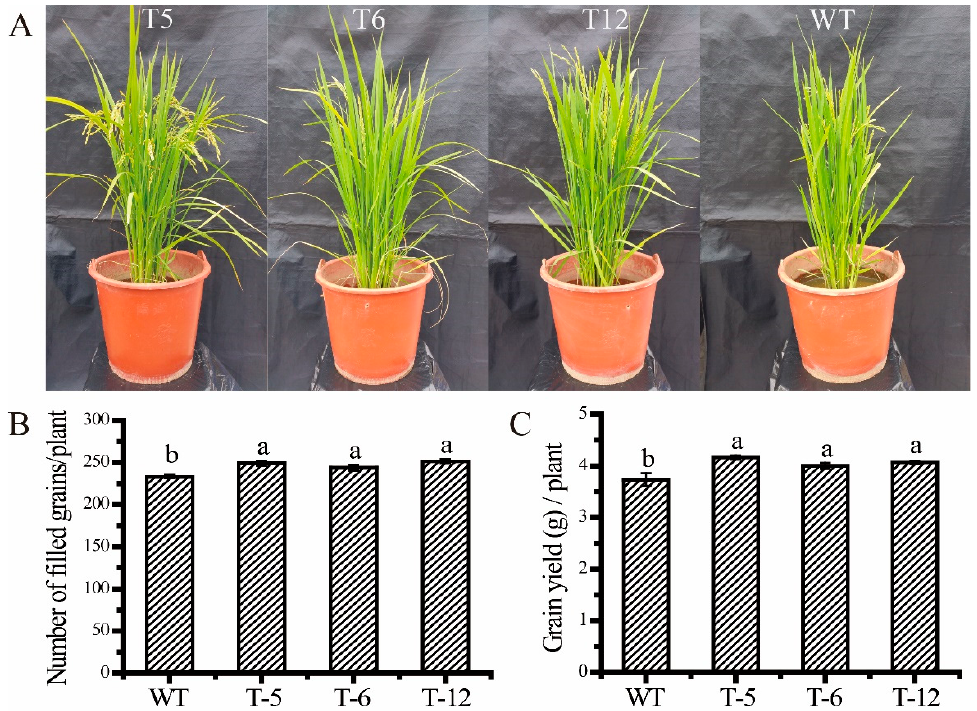
Figure 8. Phenotype and yield components of the transgenic rice in the pot experiment under low N stress. Notes: ( A ), The phenotype of the transgenic rice at the late filling stage under low N stress. ( B , C ), The number of filled grains and grain yield per plant of the transgenic rice under low N stress, respectively. WT: wild-type. T-5, T-6, and T-12: different transgenic lines. Data were presented as the mean ± standard error ( n = 3). Bars with different letters were significantly different at the p < 0.05 level.